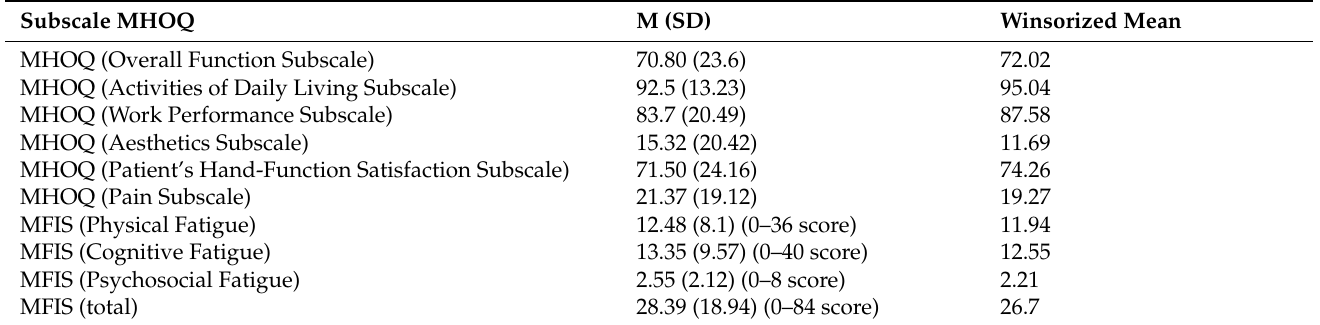
Table 5. Scores obtained in the six subscales of the MHOQ ( Michigan Hand Outcome Questionnaire ) and scores obtained in MFIS ( Modified Fatigue Impact Scale ) ( n =